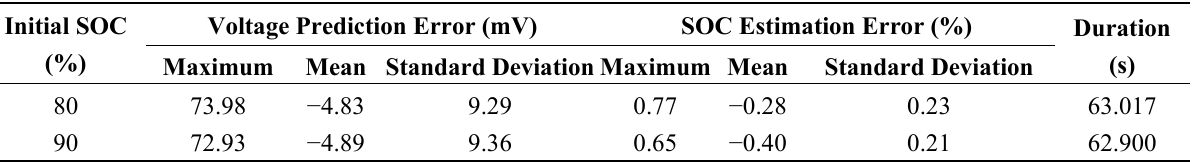
Table 7. Statistical results of the SoC estimation